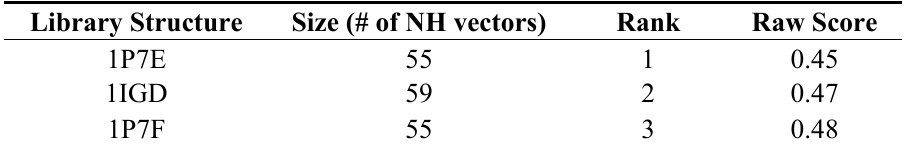
Table 2. Results of structure identification from unassigned experimental RDC data for the protein PDBID:1P7E.